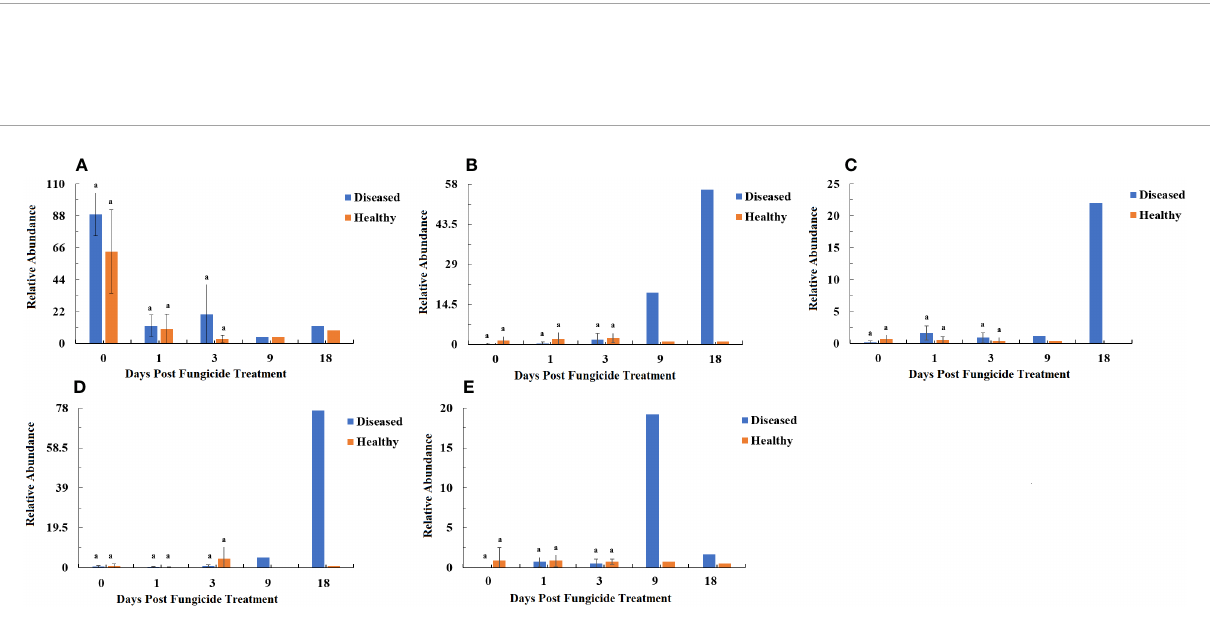
FIGURE 11 Relative abundance of fungal functional groups (modes) based on OTU annotation table with disturbance frequency level. (A) Pathotroph, (B) Pathotroph-Saprotroph, (C) Pathotroph-Saprotroph-Symbiotroph, (D) Pathotroph-Symbiotroph, (E) Saprotroph. Statistical analysis was not performed for results of diseased samples at 9 and 18 dpt as there was only one